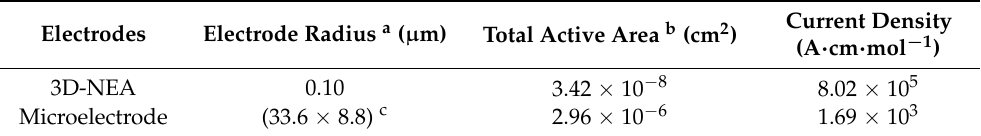
Table 1. The comparison of the physical and electrochemical characteristics of electrodes with different